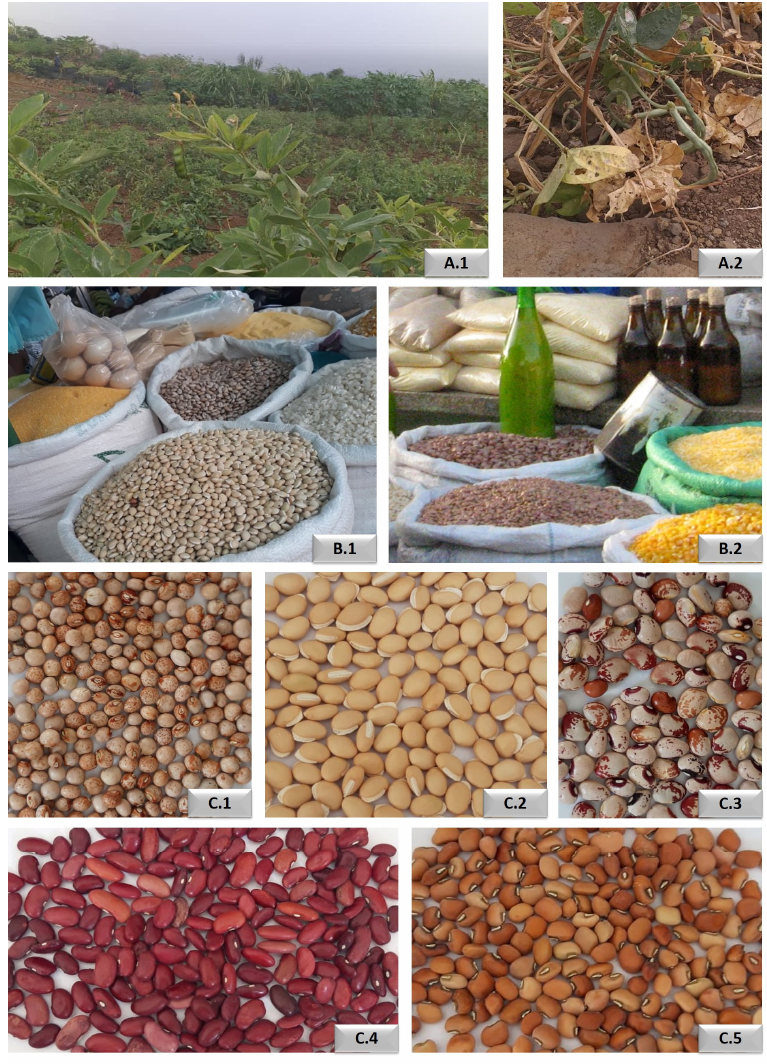
Figure 1. Studied bean species from Santiago Island. ( A ) Field beans in the Assomada region, Cajanus cajan ( A.1 ) and Vigna unguiculata ( A.2 ). ( B ) The two main Santiago markets showing different beans sold in Assomada market ( B.1 ) and Cidade da Praia municipal market ( B.2 ). C. Seeds of the studied bean species: Cajanus cajan ( C.1 ); Lablab purpureus ( C.2 ); Phaseolus lunatus ( C.3 ); Phaseolus vulgaris ( C.4 ); and Vigna unguiculata ( C.5 ).